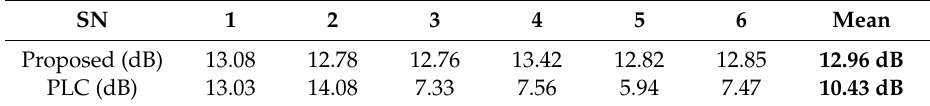
Table 6. RAIs of the real targets in red boxes.